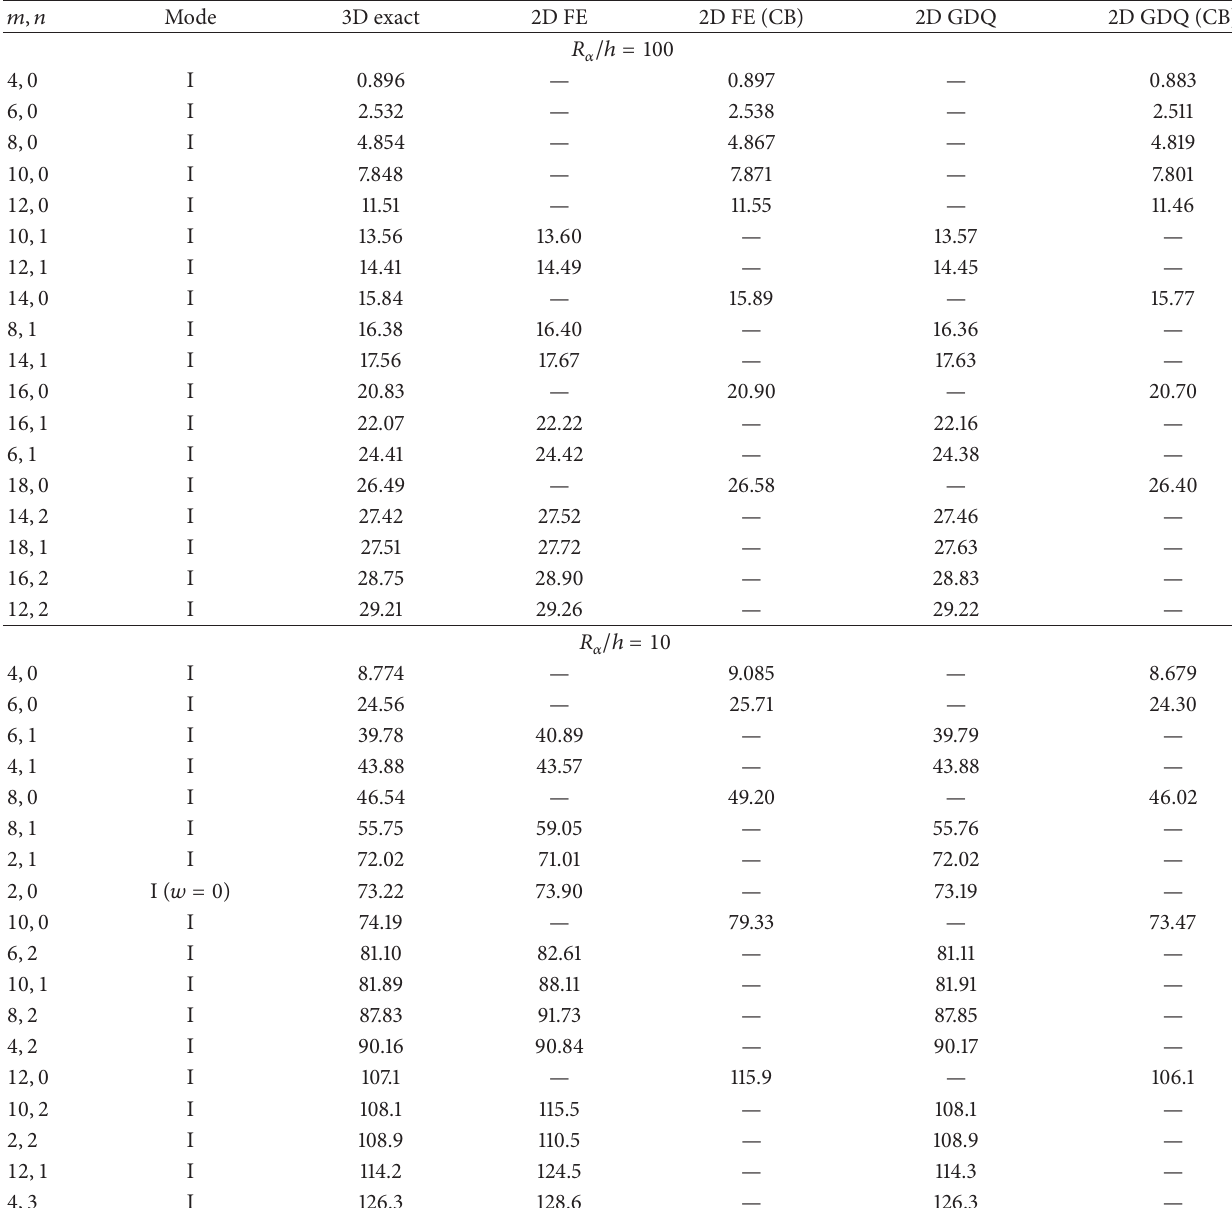
Table 3: One-layered FGM cylinder with 𝑝 = 2.0 . Analytical 3D versus 2D numerical models. Frequency 𝑓 in